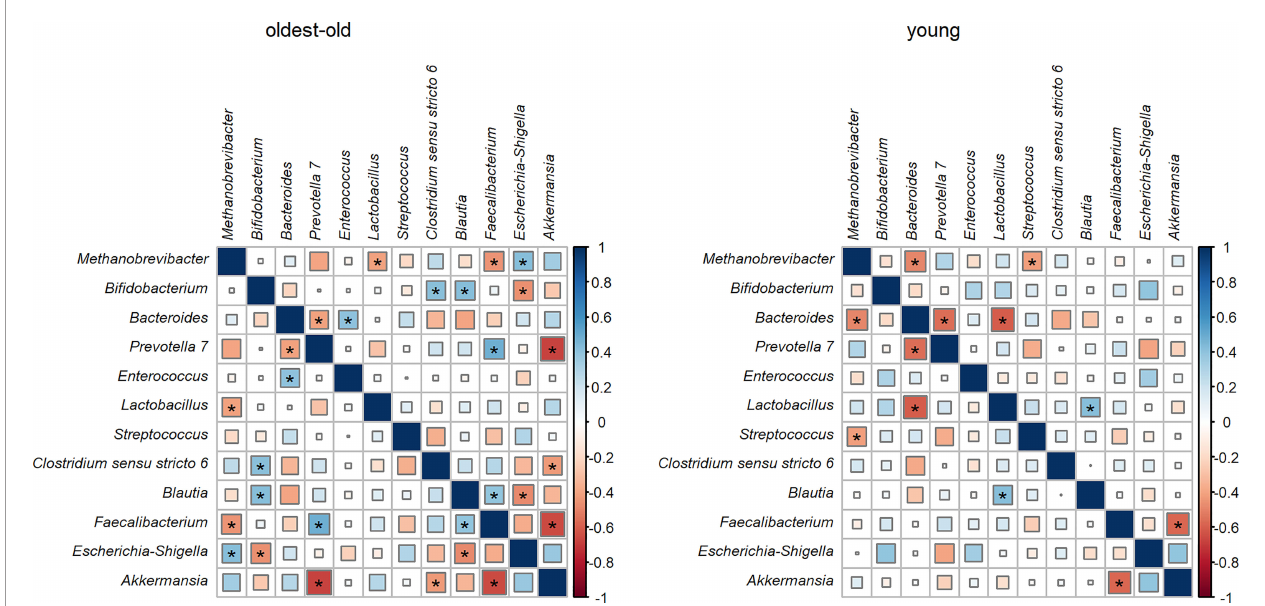
FIGURE 5 | The correlation between different bacterial abundance in the oldest-old and young groups (associations which were statistically signi fi cant without adjustment for multiple comparisons are designated by an asterisk).